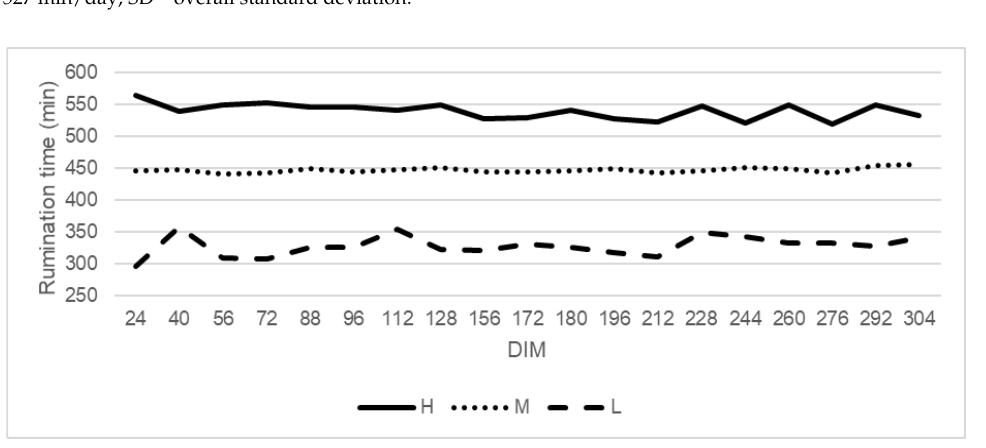
Figure 2. The trend of rumination time by cows classified as high (H), medium (M), and low (L) rumination animals. High rumination (H) from 527 min/day, medium rumination (M) from 412 to 527 min/day, and low rumination (L) to 412 min/day.